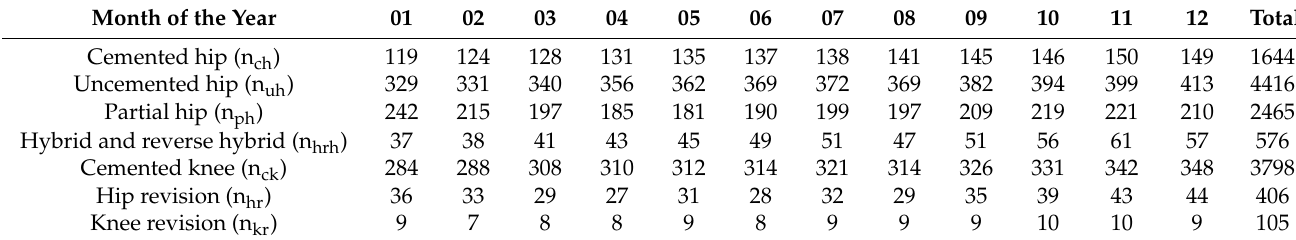
Table 4. Number of cases in 2021.